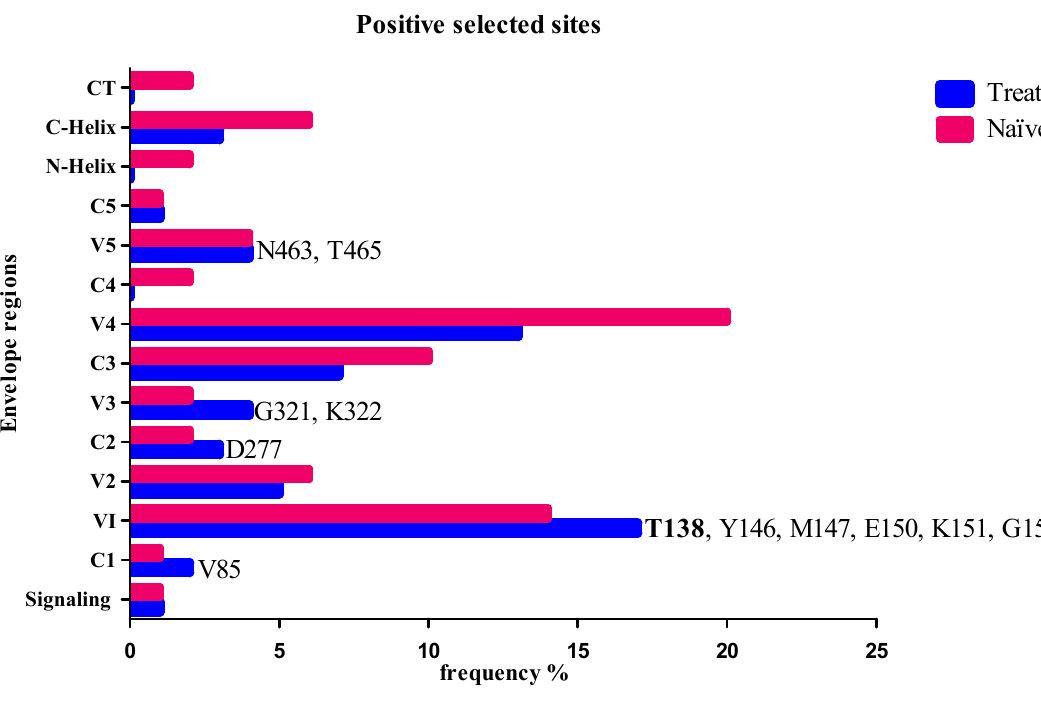
Figure 2. Positively selected amino acid codons in Env in LPV/r-treated and naïve isolates with the Bayesian probability of p > 99%. Blue shows the positively selected codons in the treated isolates, while maroon indicates the positively selected codons in the naïve isolates. Codon positions identified only in treated and not in naïve isolates are shown at the relevant env region. T138 is indicated in bold font and has a higher frequency in the treated isolates.